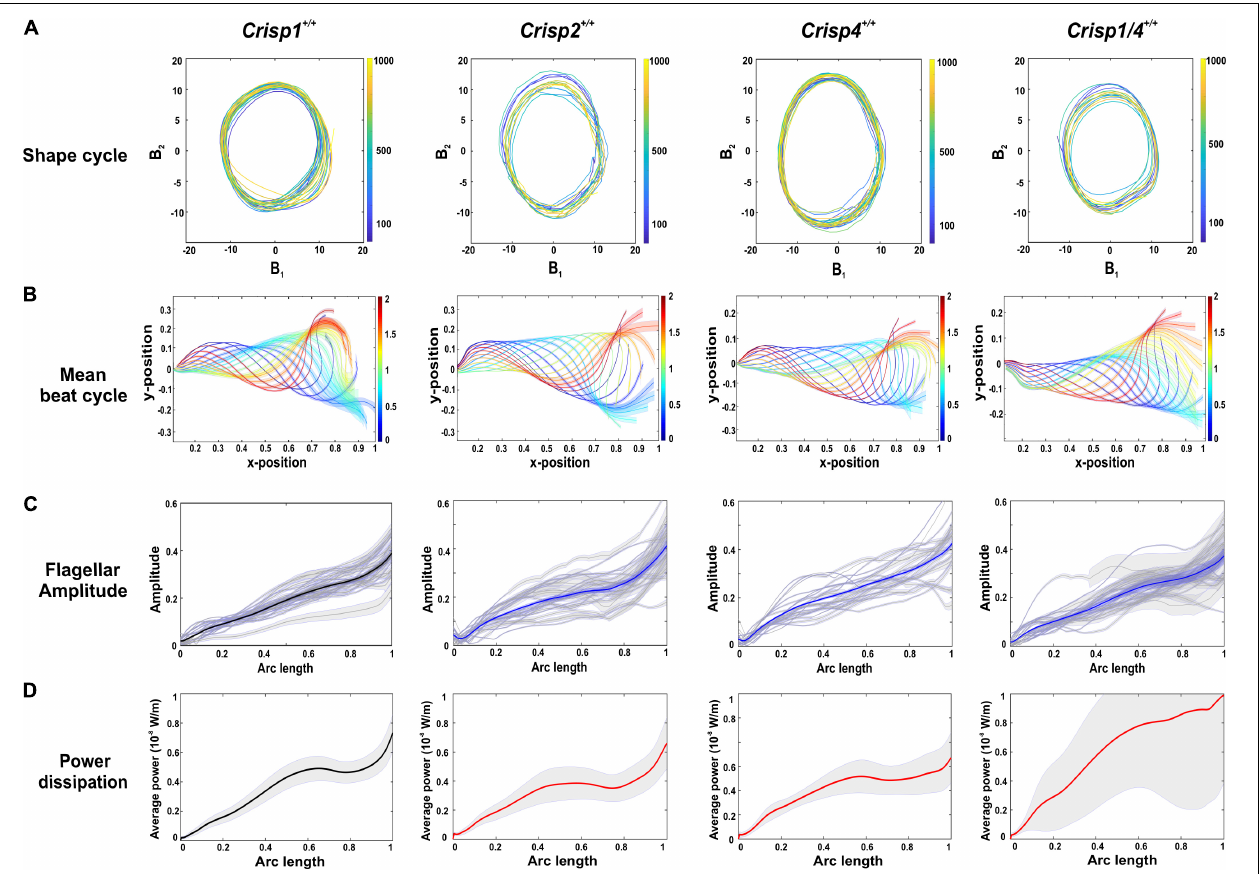
FIGURE 1 | Analysis of flagellar oscillations and kinetics across sperm from wild type mouse strains. (A) A representative analysis of the shape cycle in B-space of flagellar betting over time as visualized by plotting coefficients (B 1 and B 2 ), the two most highly contributing POD modes ( ψ 1 and ψ 2 ), against each other across the analyzed 1,000 frames. (B) A reconstruction of a representative beat cycle of sperm flagellum waveform from wild type mice from each strain. The error bars along the flagella indicates the ± SD in the sample. All lengths, including positional coordinates and the arc-length coordinate are normalized by the total sperm body length. The color spectrum represents the dimensionless fraction of the mean time-period. (C) Normalized spermatozoa flagellar beating amplitude from each mouse strain examined. Gray lines indicate the flagellar amplitude of individual sperm sample and blue lines indicate the mean flagellar amplitude. The gray zone along the flagella indicates the ± SEM in the sample. (D) An analysis of power dissipation (10 − 8 W/m) along the flagella. The bold line indicates averaged data across the sperm population ± SEM indicated in the gray zone. Crisp1 + / + is denoted in black bold line as this will used as representative graph for comparison with knock out mice. Crisp2 + / + , Crisp4 + / + , and Crisp1/4 + / + are denoted in bold red lines. For all of (A–D) the strain from which wild type mice and sperm were derived is indicated above each column and a total of N = 25–30 sperm/mouse strain were